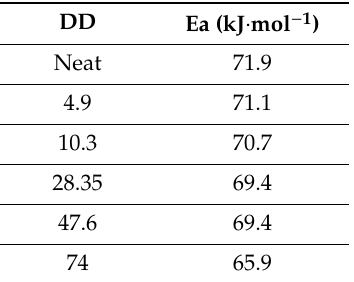
Table 2. Polymerization activation energies of the DGEBA / DDS reactive systems filled with MWNT (0.7% by weight) for di ff erent dispersion degrees (DD).